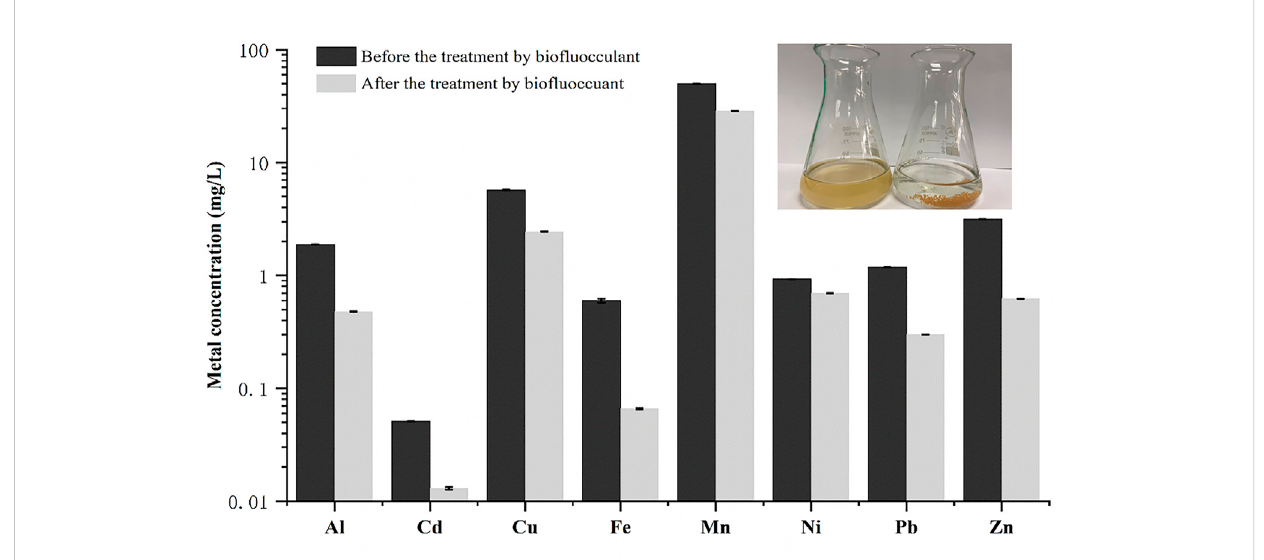
FIGURE 5 The effect of the bio fl occulant on the metal ion concentration of the real acid wine wastewater.